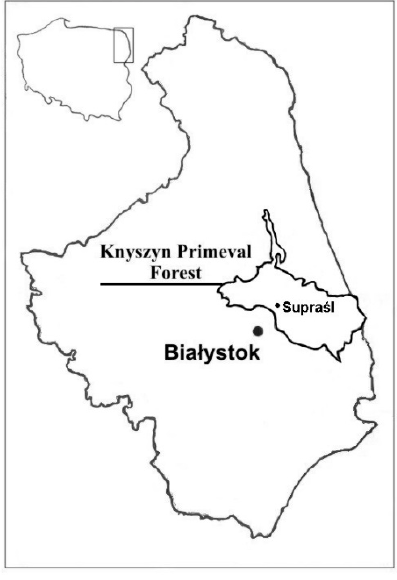
Figure 1. Location of Suprasl.